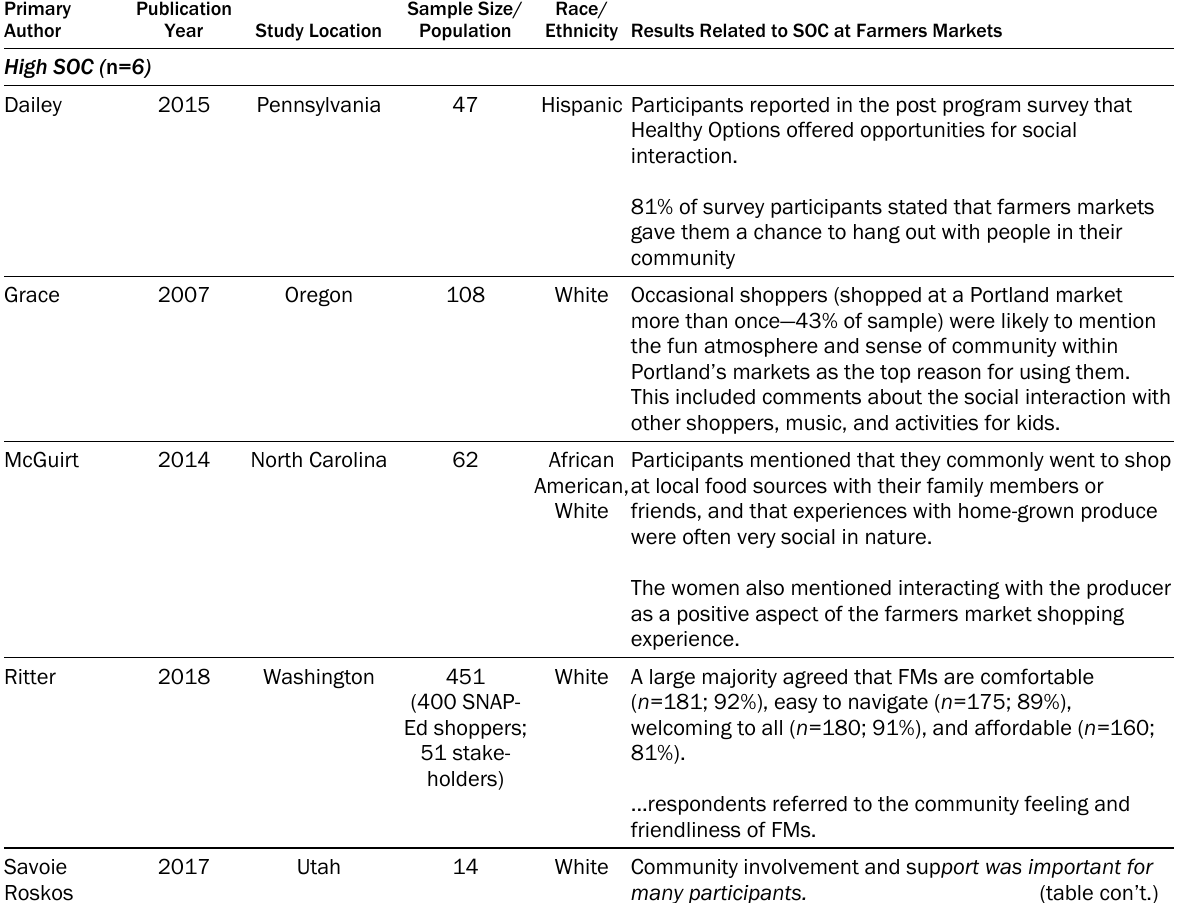
Table 3. Summary of Articles Related to Sense of Community Among Farmers Market (FM) Shoppers Living with Low Incomes ( n